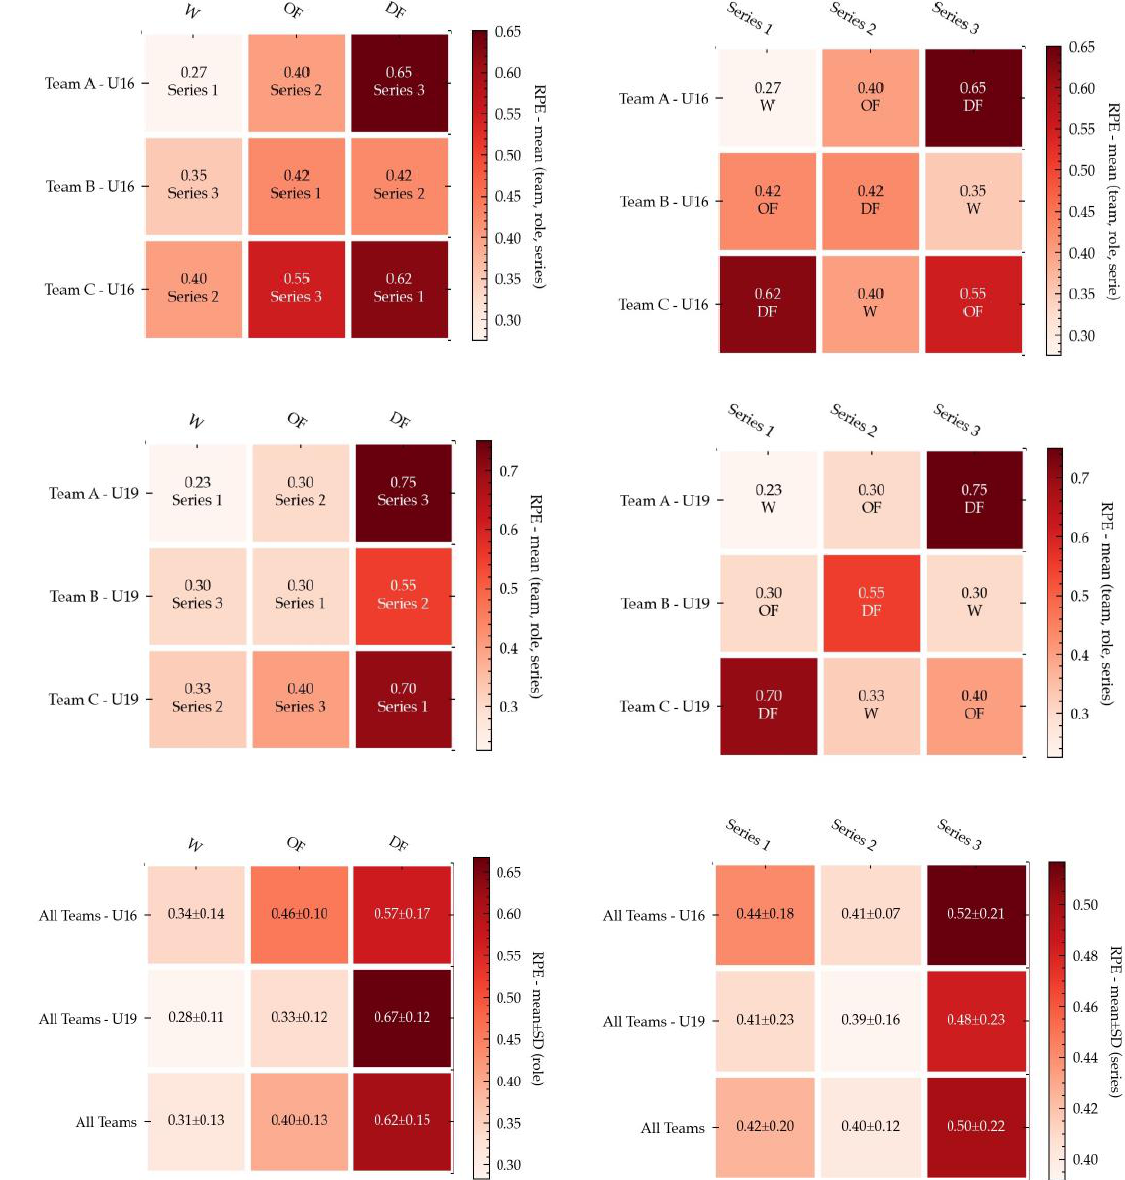
Figure 4. Annotated heatmaps for the study of the RPE variable (U16, U19, and datasets merged). The following figure presents six heatmaps for the study of internal load in the three datasets, in which the first row shows U16 results, the second shows U19 results, and the third shows merged dataset results. The three heatmaps in the left column focus on the comparison among roles (OF, DF, and W), while heatmaps in the right column focus on the comparison between series (Series 1, Series 2, and Series 3). Dark colors show a higher PHYD rate, whereas the light color indicates less prevalence.